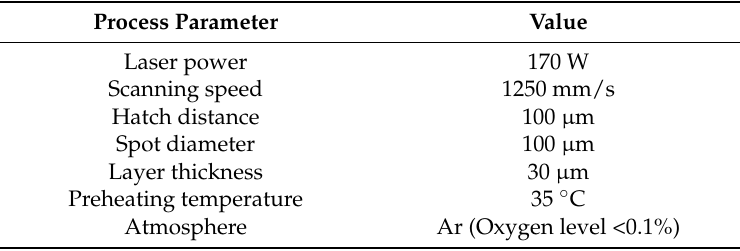
Table 2. Process parameters of used Ti-6Al-4V